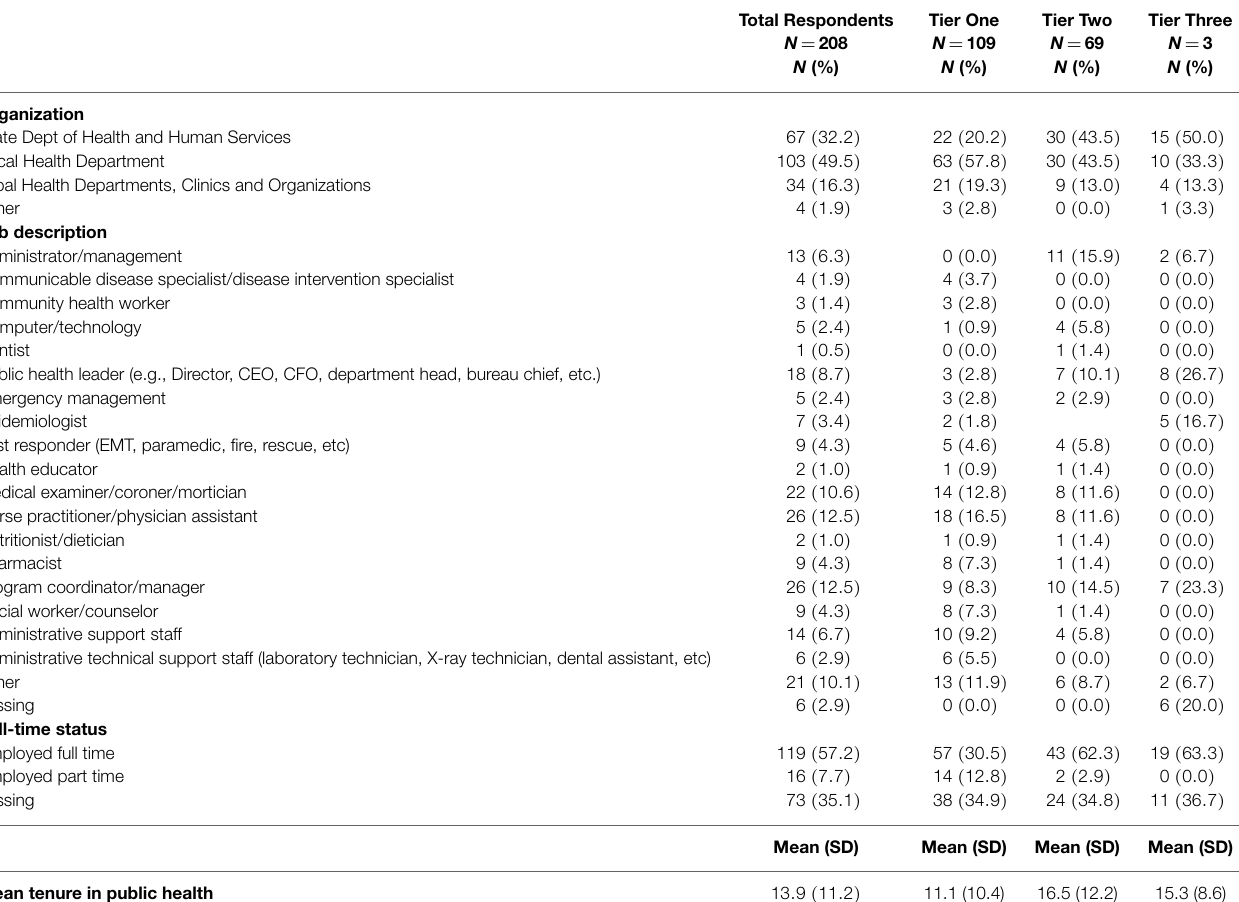
TABLE 2 | Employment characteristics of respondents